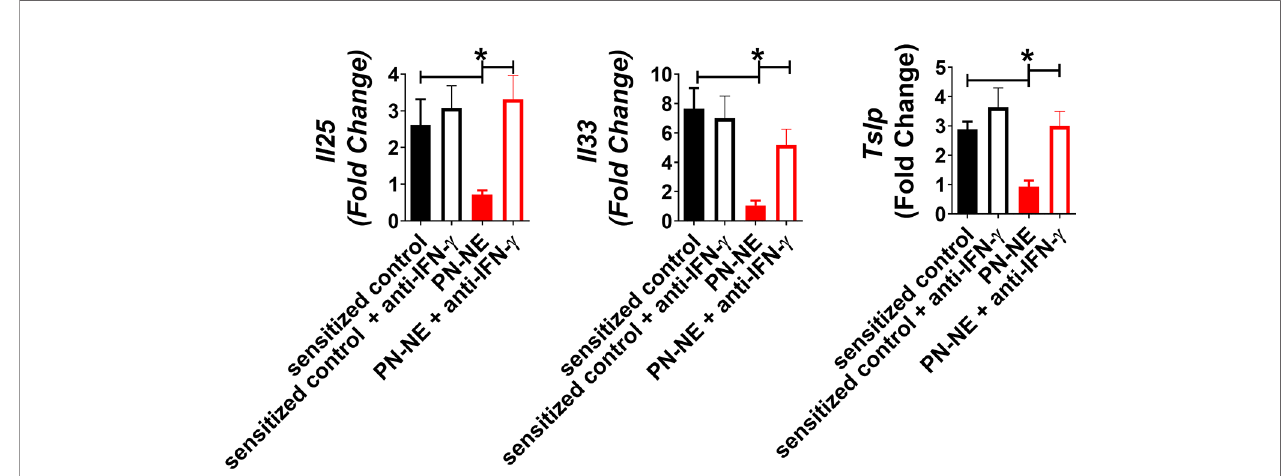
FIGURE 6 | IFN- g is required for suppression of alarmins by NE allergy vaccines. Mice were sensitized with OVA and peanut-alum and treated i.n. with 3 administrations of PBS (sensitized control) or peanut-NE (PN-NE). Mice were challenged orally with OVA and IFN- g was depleted during the challenge phase. Duodenum samples were homogenized and mRNA was extracted to determine relative gene expression compared to GAPDH. Statistically signi fi cant differences (p < 0.05) are indicated by